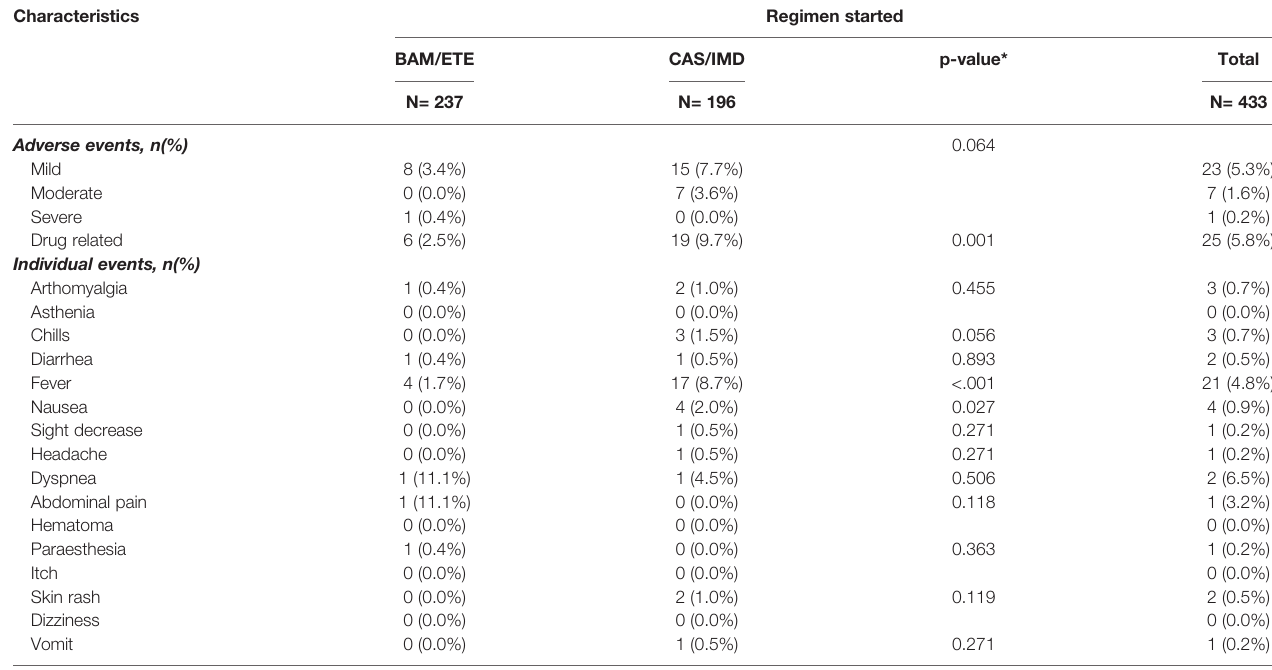
TABLE 4 | Proportions of participants reporting speci fi c adverse events by intervention group.